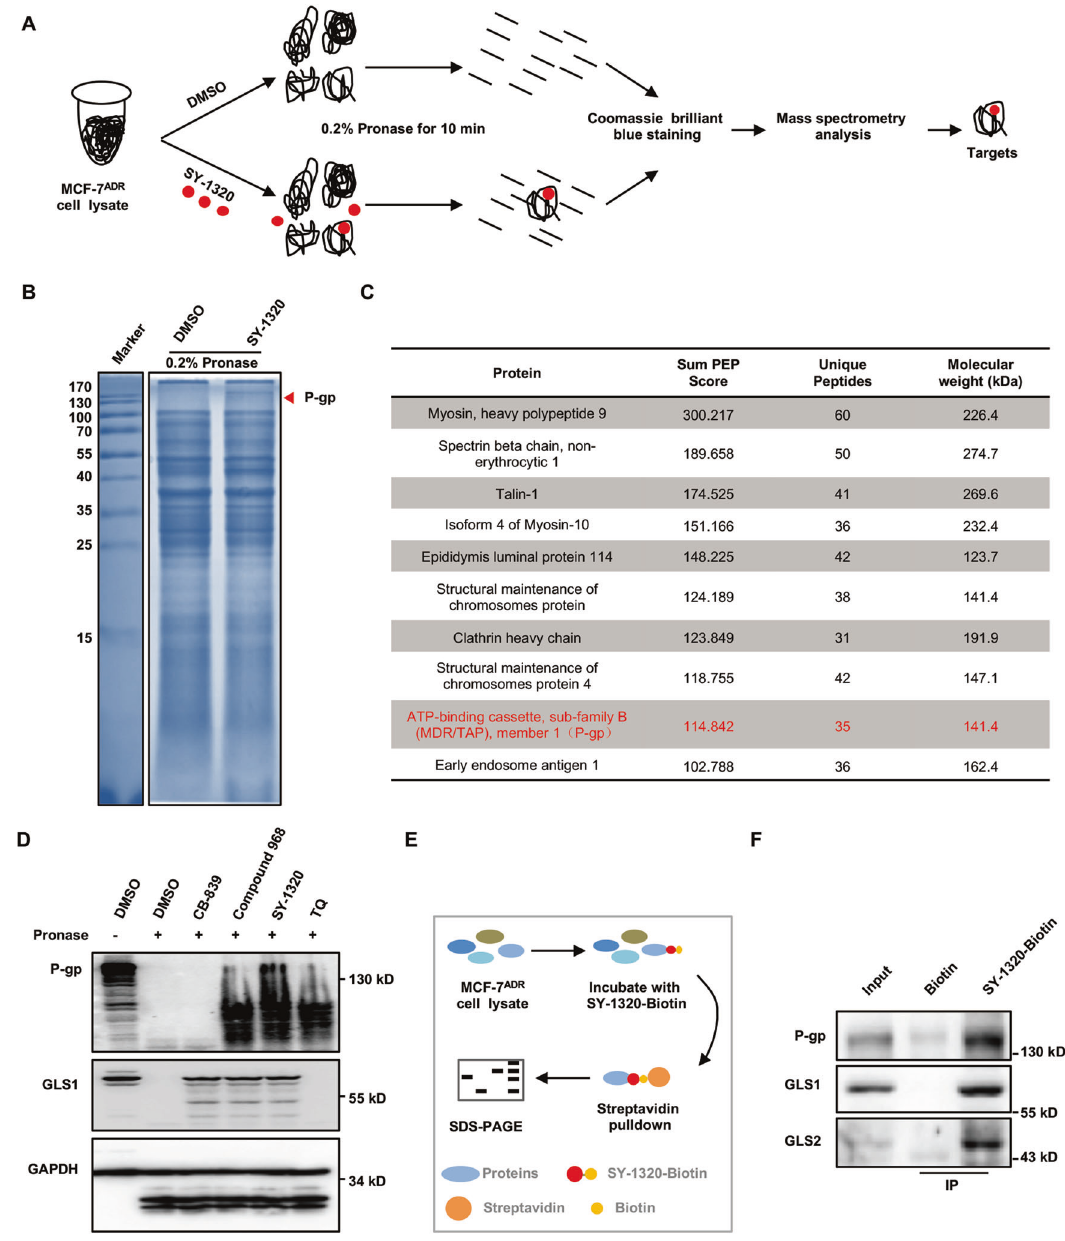
Fig. 5 DARTS identi fi es that SY-1320 could target the multidrug resistance protein, P-gp. A Scheme of DARTS. B MCF-7 ADR cell lysates were incubated with DMSO or SY-1320 (1 mM) for 2 h at 4 °C and then subjected to pronase digestion for 10 min, after which Coomassie blue staining was performed. C Mass spectrometric results showed that P-gp might be a potential target for SY-1320. D Direct binding between P-gp and compound 968 or SY-1320 was identi fi ed by DARTS. Tariquidar (TQ, a P-gp-speci fi c inhibitor) served as a positive control. E